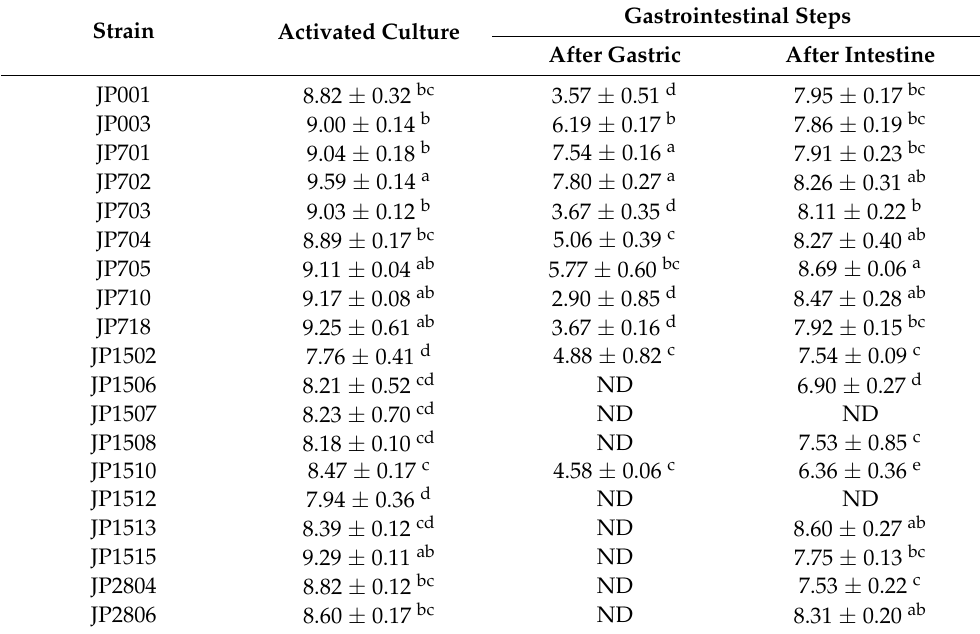
Table 2. Tolerance to gastric and intestinal juice of 19 LAB strains (Log10 CFU/mL).